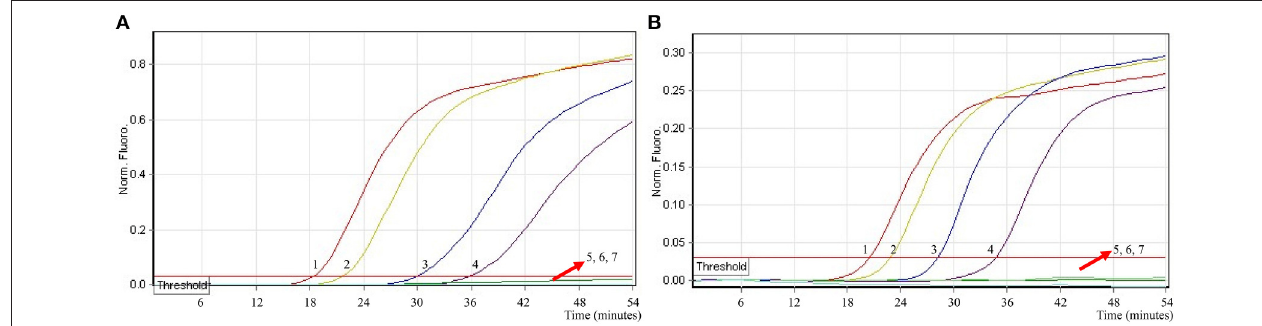
FIGURE 9 | The sensitivity of multiplex MERT-LAMP assay for simultaneously detecting two target pathogens in artificially contaminated milk samples. Two sets of MERT-LMAP primers targeting ipaH and invA genes were added to a reaction tube. (A,B) were simultaneously generated from Cy5 (labeling Shi -EFIP of ipaH ) and Hex (labeling Sal -EFIP of invA ) channels, respectively. Sensitivity of multiplex-MERT-LAMP for simultaneously detecting Shigella (A) and Salmonella (B) in artificially contaminates milk samples was analyzed by real-time format, and signals 1, 2, 3, 4, 5, 6, and 7 represent Shigella DNA levels of 5800, 580, 58, 5.8, 0.58, and 0.058 CFU per reaction and negative control; Salmonella DNA levels for 6400, 640, 64, 6.4, 0.64, and 0.064 CFU per reaction and negative control. The LoD of multiplex MERT-LAMP assay for Shiglla detection in artificially contaminates milk samples was 5.8 CFU per tube, and the LoD of multiplex MERT-LAMP for Salmonella detection in artificially contaminates milk samples was 6.4 CFU per reaction.